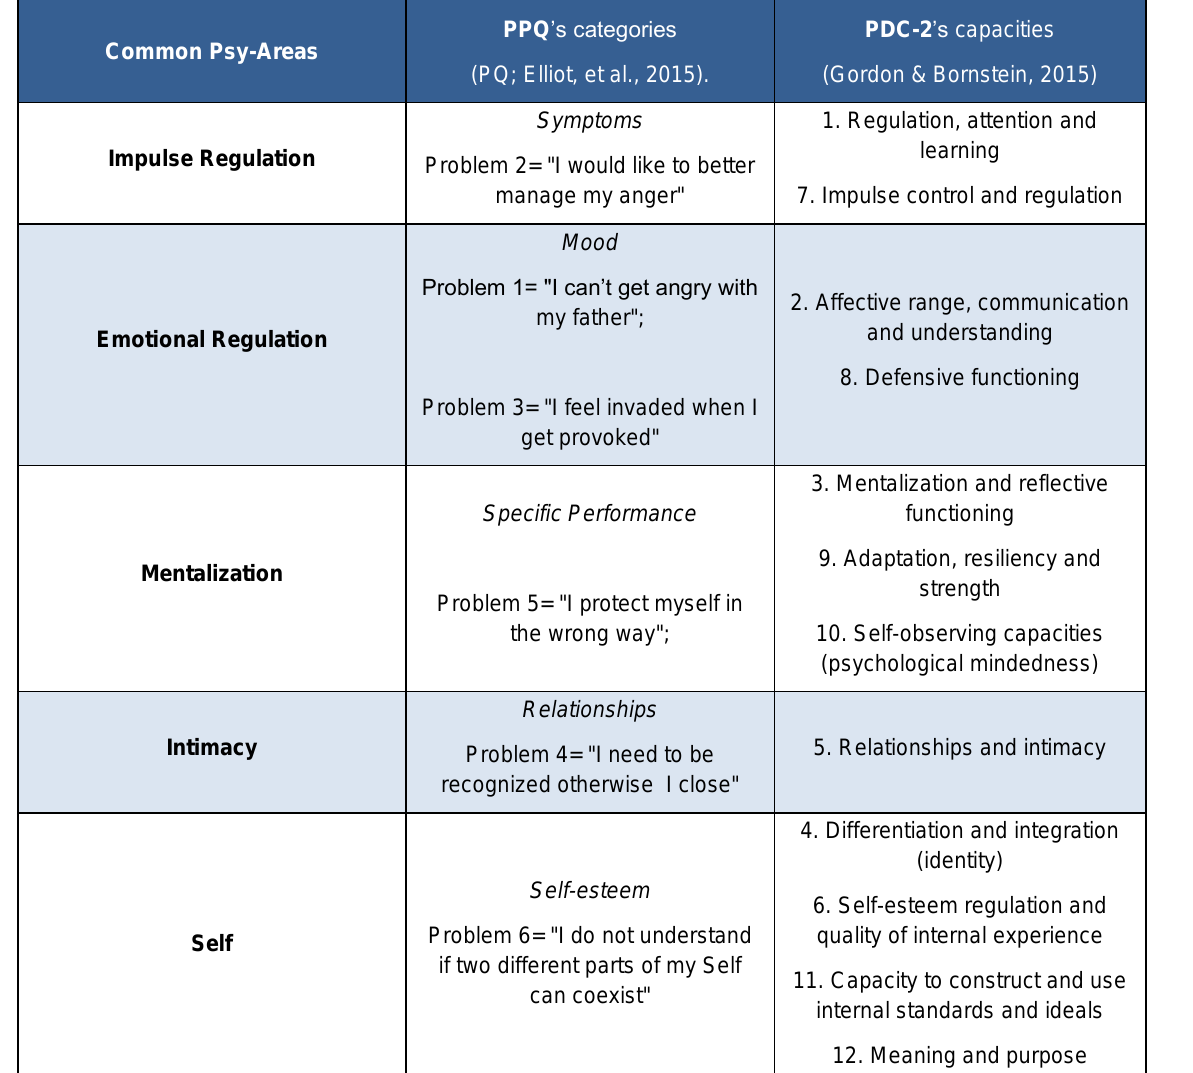
Table 7: Common-topic psychological areas between PPQ’s categories and PDC-2’s capacities